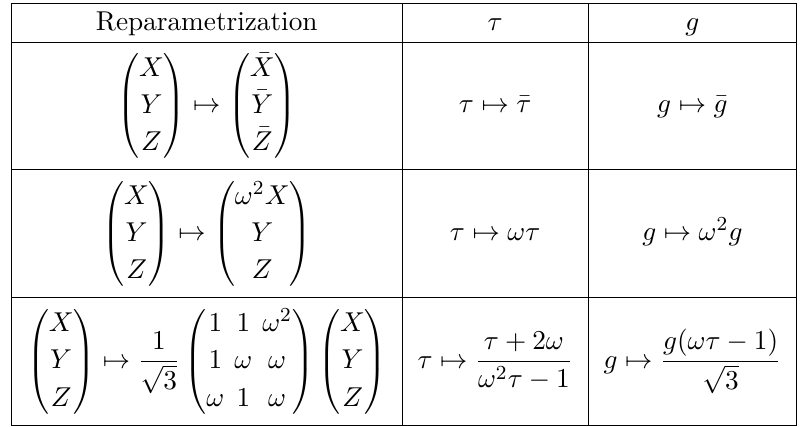
Table 1 . Generators of the duality group G d . Here ω = e 2 πi/ 3 is a cubic root of unity. There is a slight mismatch between this table and the one given in [47]; we believe the results here are the correct ones. The difference does not affect any computation in either paper.